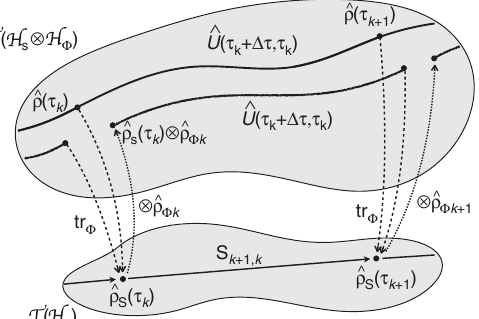
Fig. 7 Markovian regime and the evolution of the reduced density operator. This is a schematic representation of the condition for the validity of the Markovian regime for the evolution of the open spin system. The full (unitary) evolution in the space of trace-class operators describing the universe, T ( H s ⊗ H Φ ), must induce discrete dynamical maps S k + 1, k on the space of trace-class operators describing the spin system, T ( H s ), in such a way that, for m ≥ l ≥ k , S m , l ⋅ S l , k = S m , k used in the literature to argue against the physical reality of the Unruh temperature, with T U = a /(2 π ) emerging naturally from the thermalization process observed for the spin system. There-